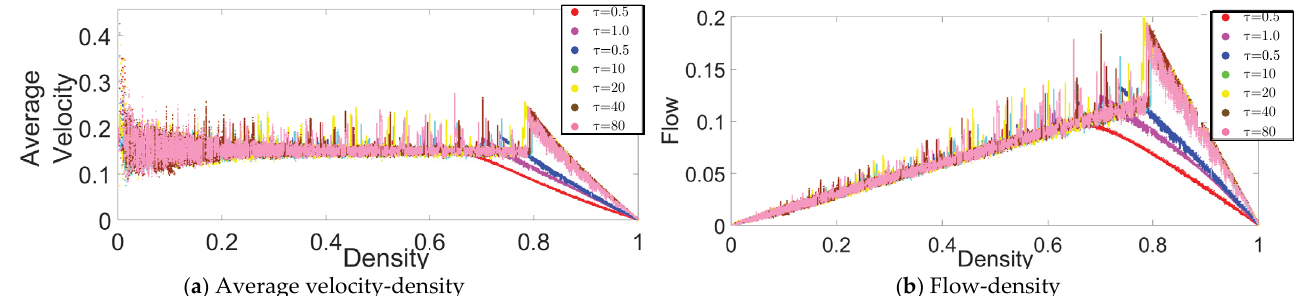
Figure 8. A fundamental diagrams from the ATM simulations with various τ values: ( a ) average velocity ( cells / time step )—density relationship and ( b ) flow ( ants / time step )—density relationship. Variables other than τ were kept constant: L = 1000 cells , σ sat = 80 p units / cell , v min = 0.15 cells / time step , r e = 0.02.